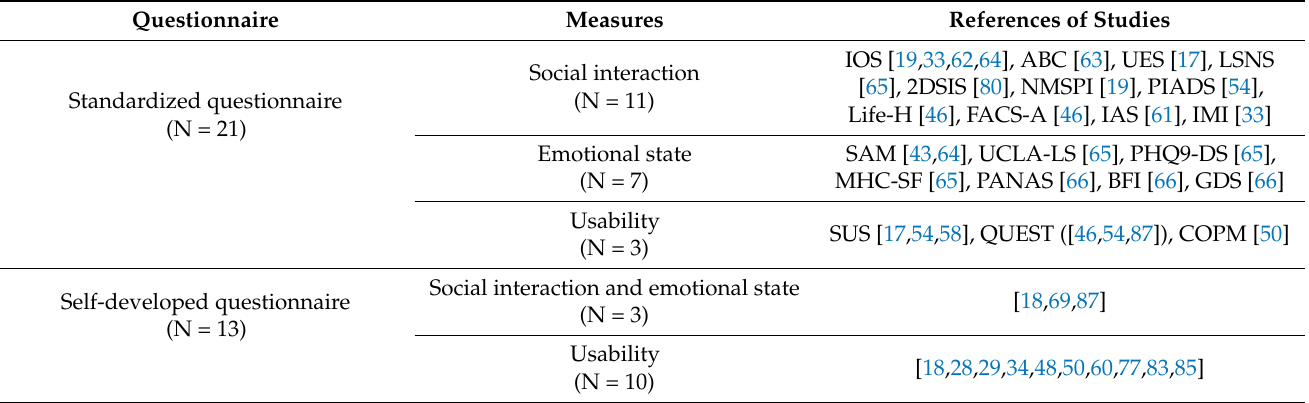
Table 3. Questionnaires for measuring SASs (“N” stands for the number of questionnaires). Questionnaire Measures References of